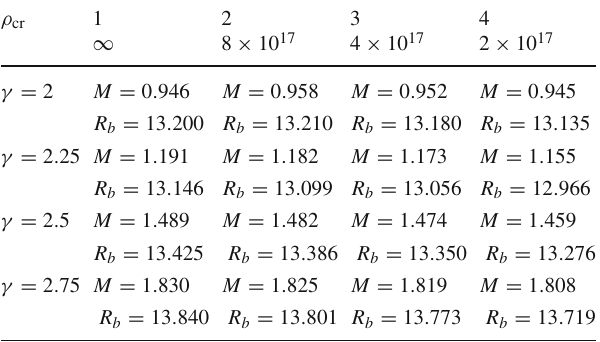
Table 2 Comparison of the radii of ECT-inspired compact objects with polytropic EoS and central density ρ 0 = 6 . 5 × 10 14 g / cm 3 for different values of the polytropic index. The case of γ = 2 . 5 is illustrated in Fig. 4. Masses are in units of solar masses, radii are in km, densities are in g / cm 3